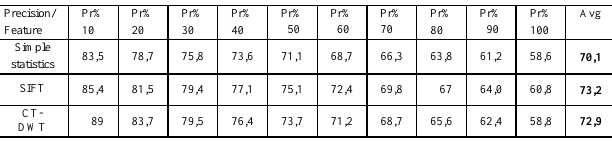
Table 6. Applying improved labelling to the other methods (SIFT, CT-DWT).